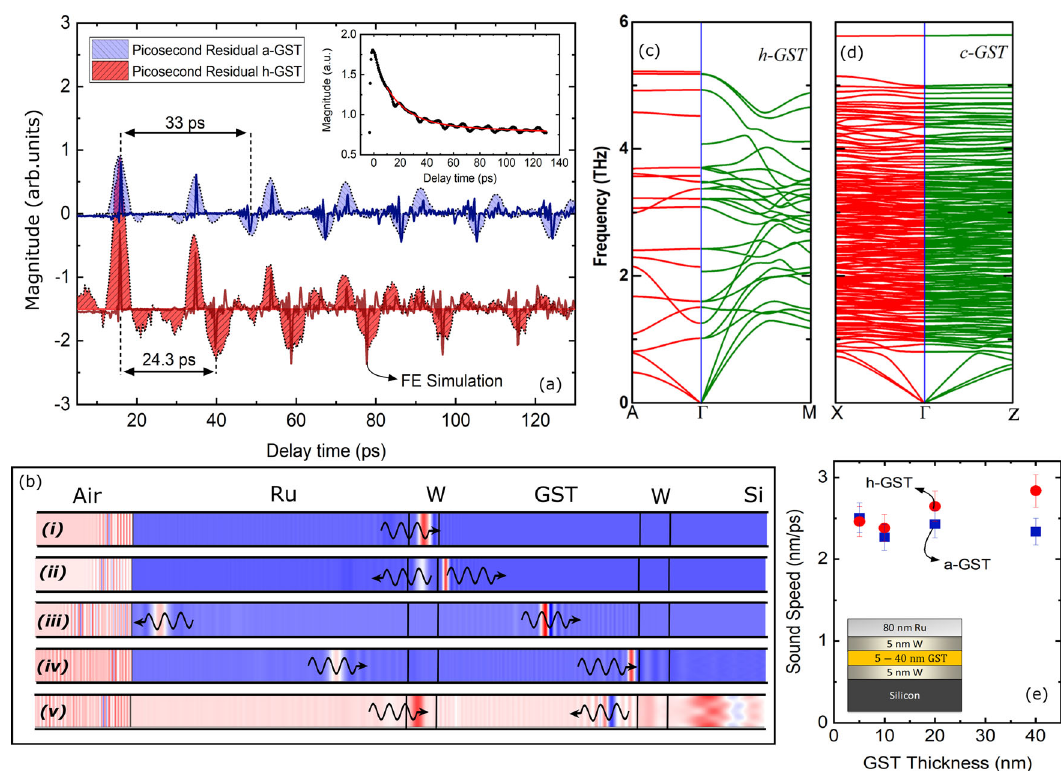
Fig. 5 Sound speed measurements for thin GST fi lms. a Picosecond ultrasonic measurements for 40 nm of a-GST (blue) and 400 °C annealed h-GST (red). The "humps" and "troughs" corresponds to the re fl ection of strain waves off of W/GST and GST/W interfaces, respectively. The solid lines correspond to fi nite-element simulation of strain wave propagation across different layers. b A representation of strain wave and how it propagates and re fl ects off of various interfaces. c , d Calculated phonon dispersions for h-GST and c-GST. e Sound speed measurements for different thicknesses of a-GST and h-GST. The error bars are calculated based on 10% uncertainty for the GST fi lm